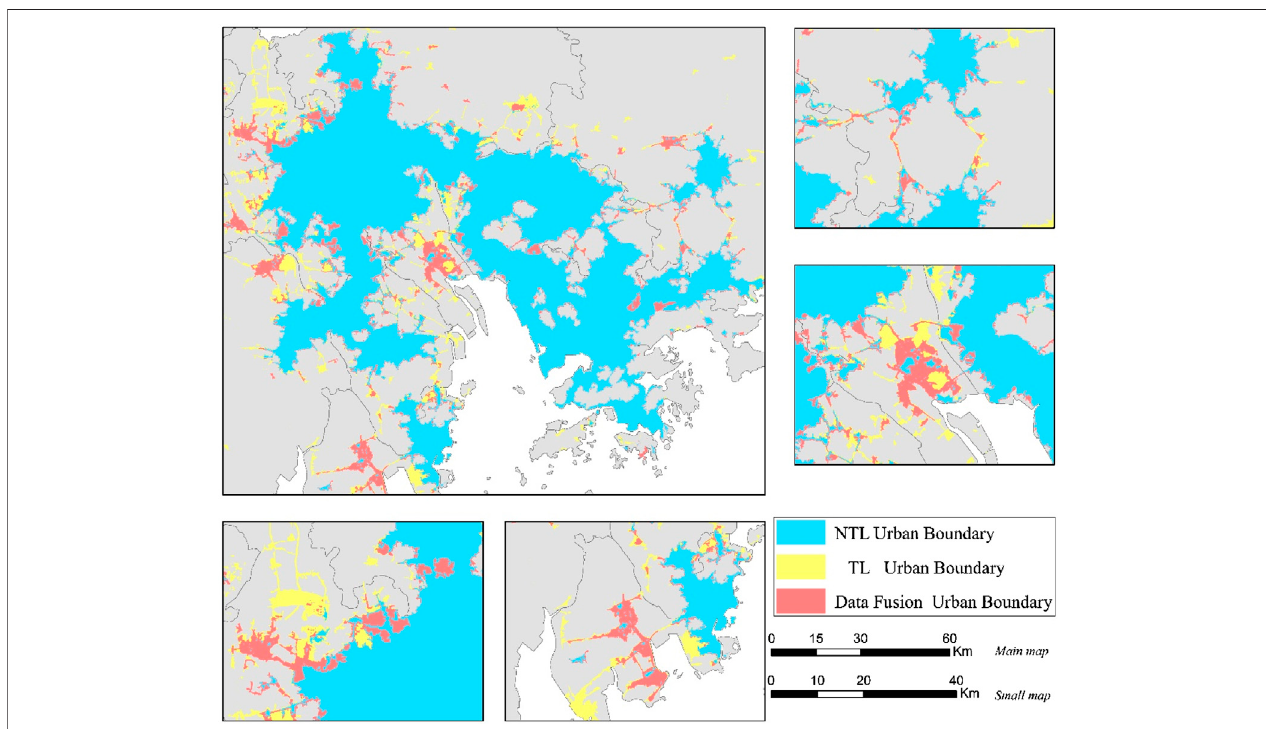
FIGURE 9 | Comparison of urban agglomeration boundary delineated using different